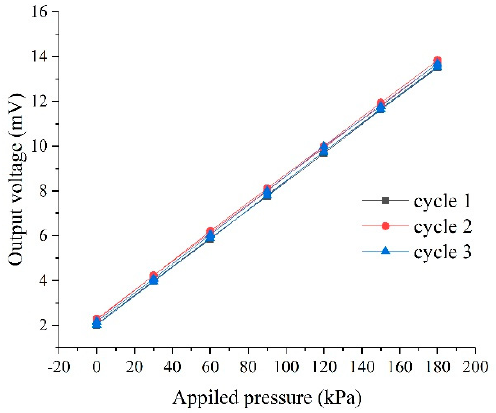
Figure 6. Relationship between output voltage and applied pressure.